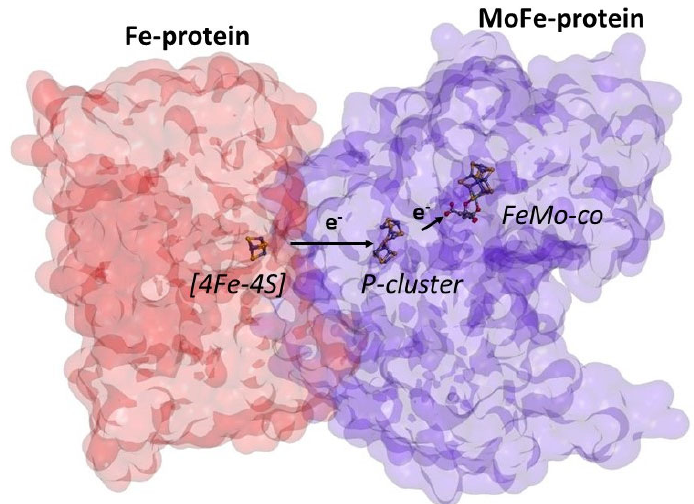
active site. This precise control allows nitrogenase to favour conditions for N 2 reduction rather than the production of H 2 [27].